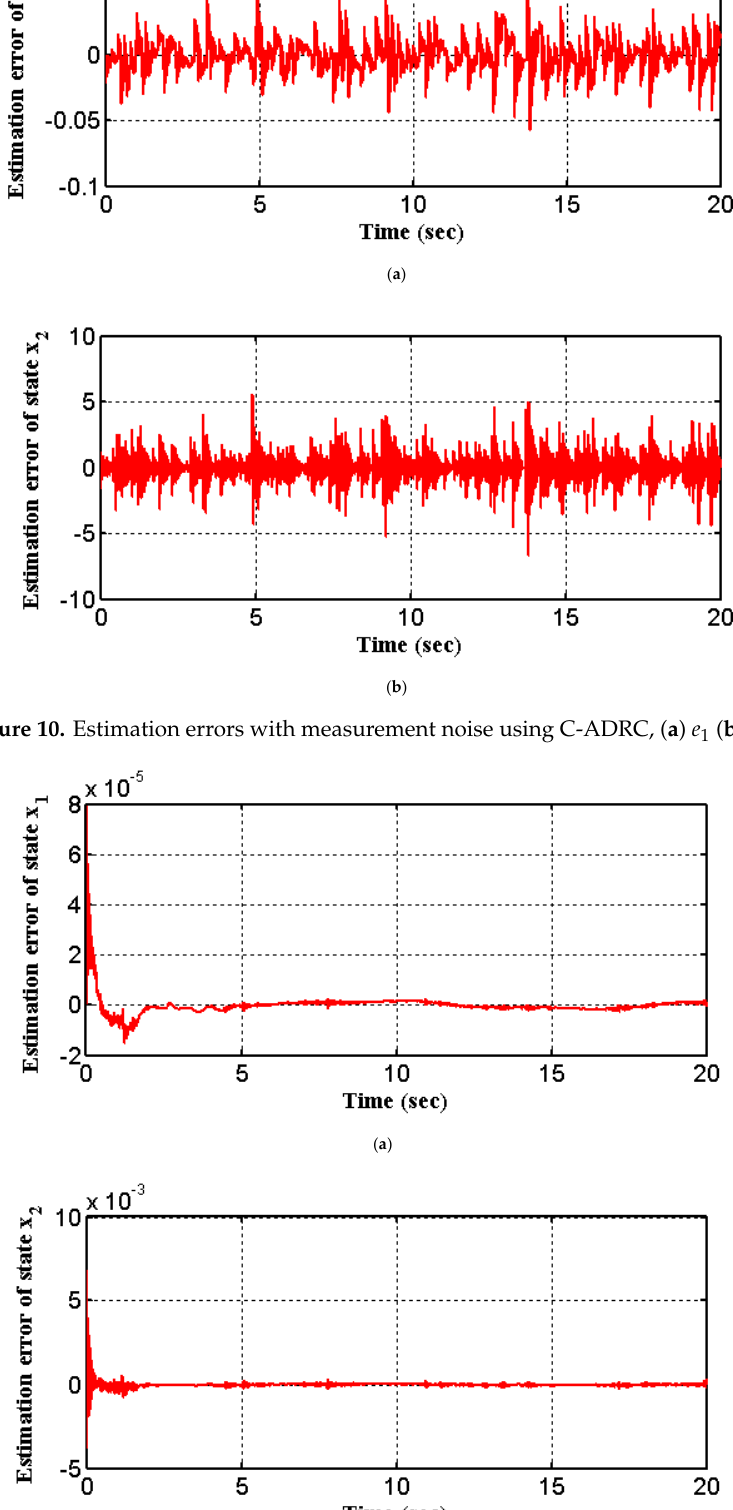
Figure 11. Estimation error without measurement noise using N-ADRC, ( a ) (cid:1857) (cid:2869) ( b ) (cid:1857) (cid:2870) .